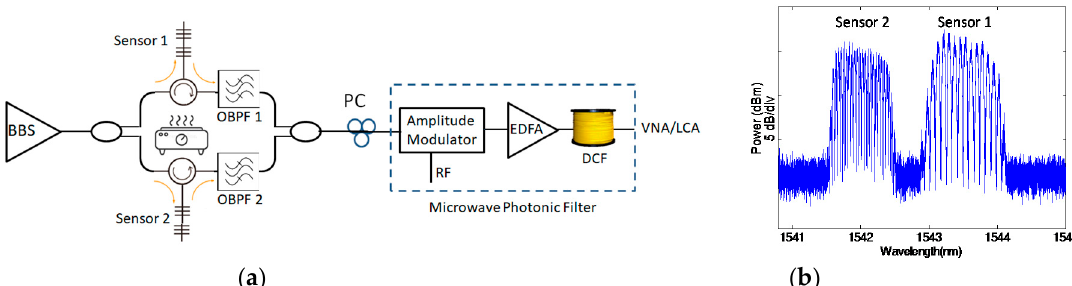
Figure 4. ( a ) Experimental setup for interrogating two temperature sensors based on single bandpass MWP filtering and ( b ) spectral response of the two in-fiber FP cavity sensors.